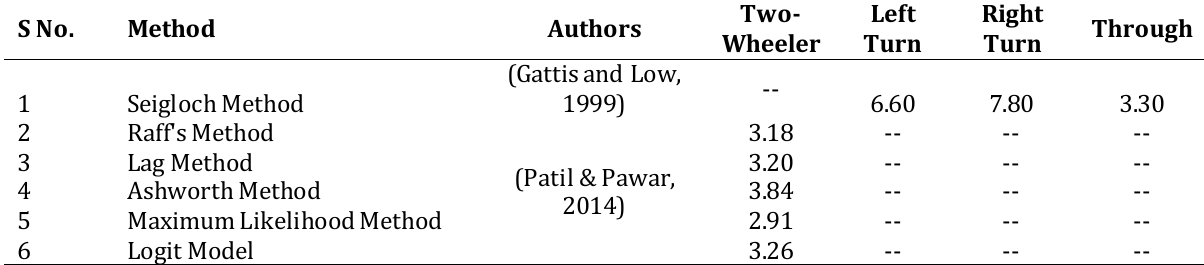
Table 9: Critical gap values for T-intersection for heterogeneous traffic condition S No.